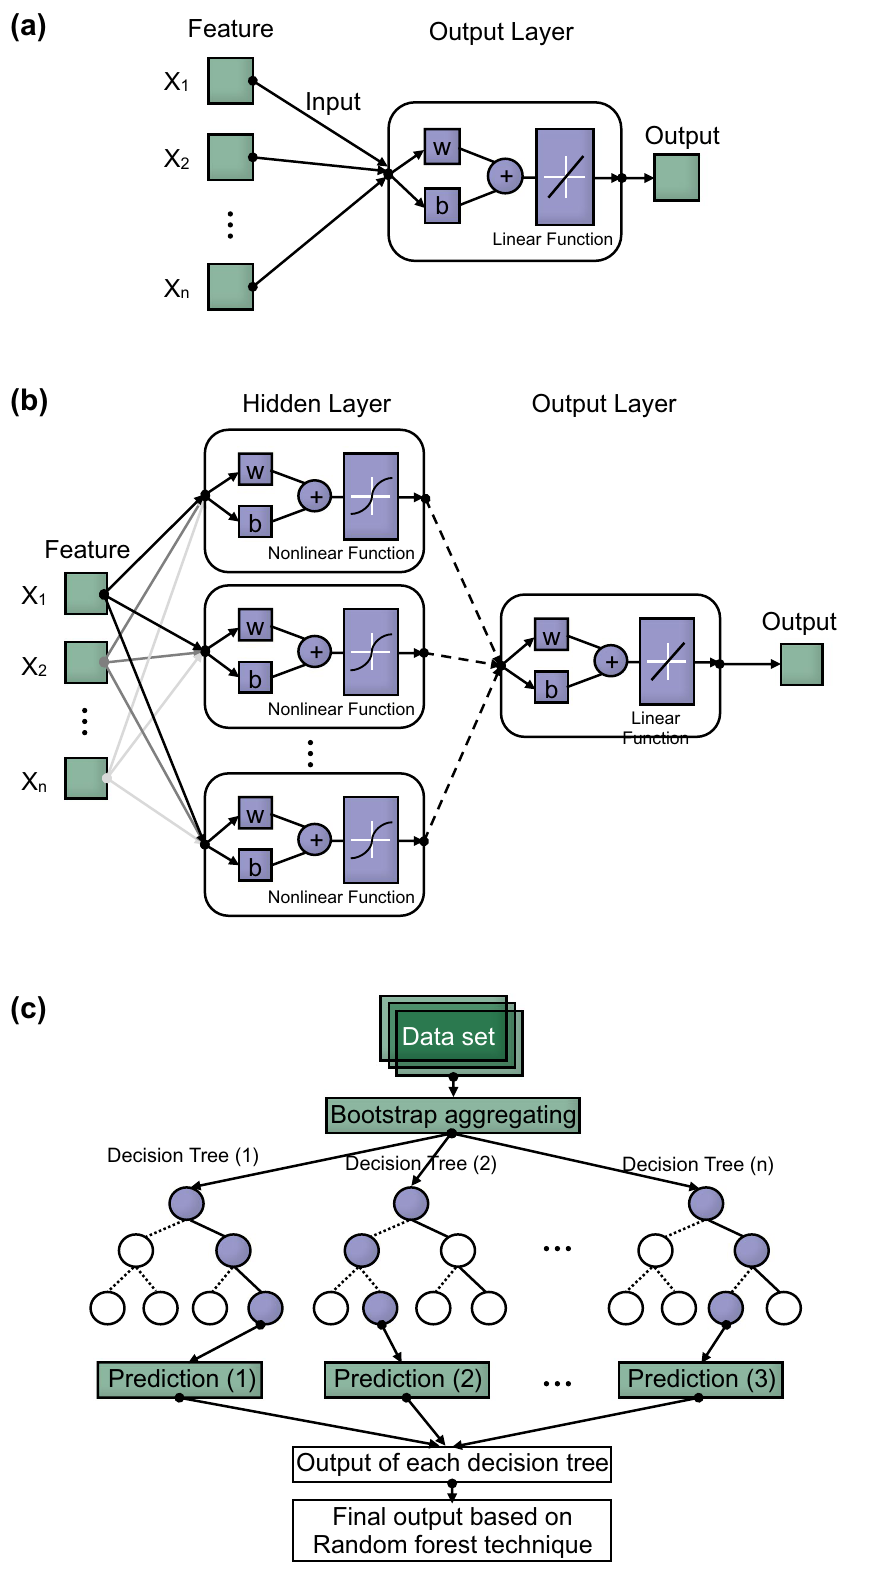
Figure 1. Architecture of machine learning algorithm: ( a ) linear regression; ( b ) neural network; ( c ) random